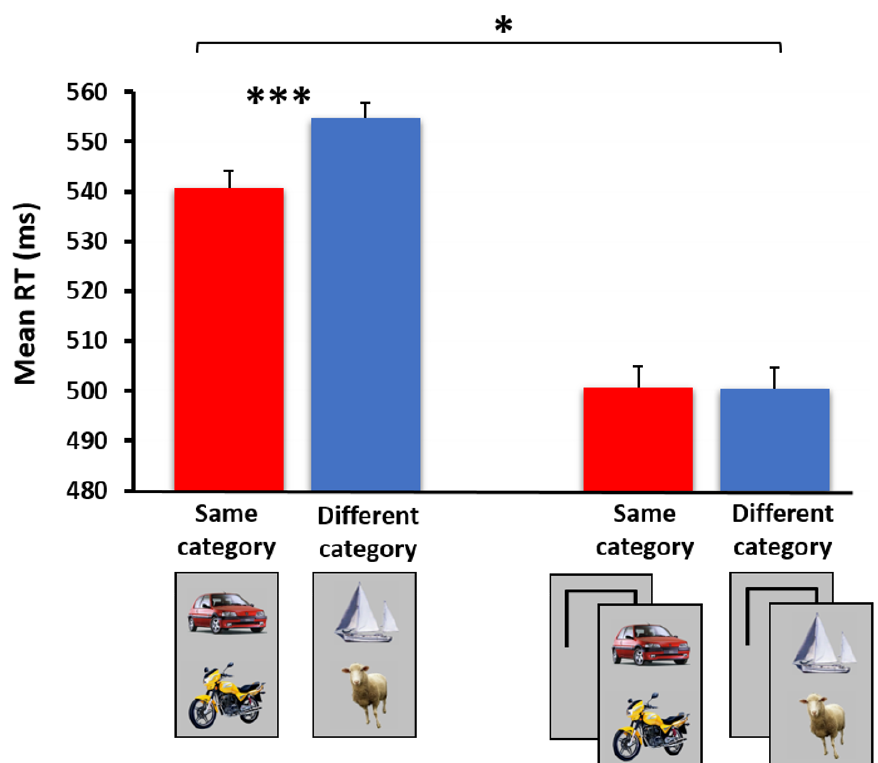
Figure 3. The categorical relation effect among the nontarget stimuli in the basic experimental version (i.e., both stimuli are attended, left) vs. the spatial cuing experimental version (i.e., only one of two stimuli is fully attended and relevant to task requirements, right). The black frames on the right denote the cue, briefly appearing prior to stimulus presentation in an upper (50%) or a lower location. A statistically significant between-subject interaction was obtained when comparing the results of the two experiments (N = 21 in each). * p < 0.05, *** p < 0.001. The full results are presented in